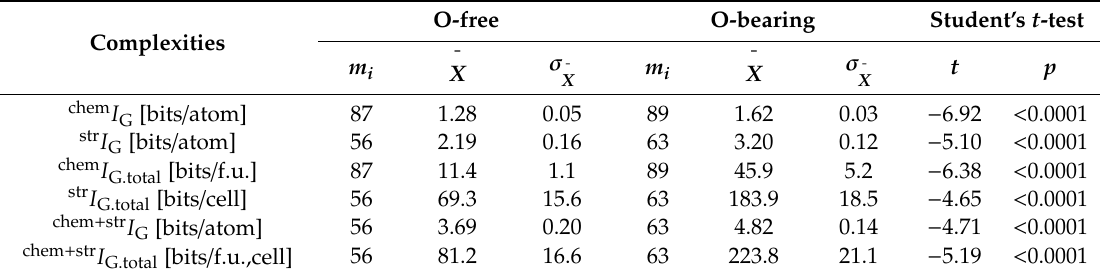
Table 4. Chemical, structural, and crystallochemical complexities of two groups (O-free and O-bearing) tellurium minerals *. Complexities